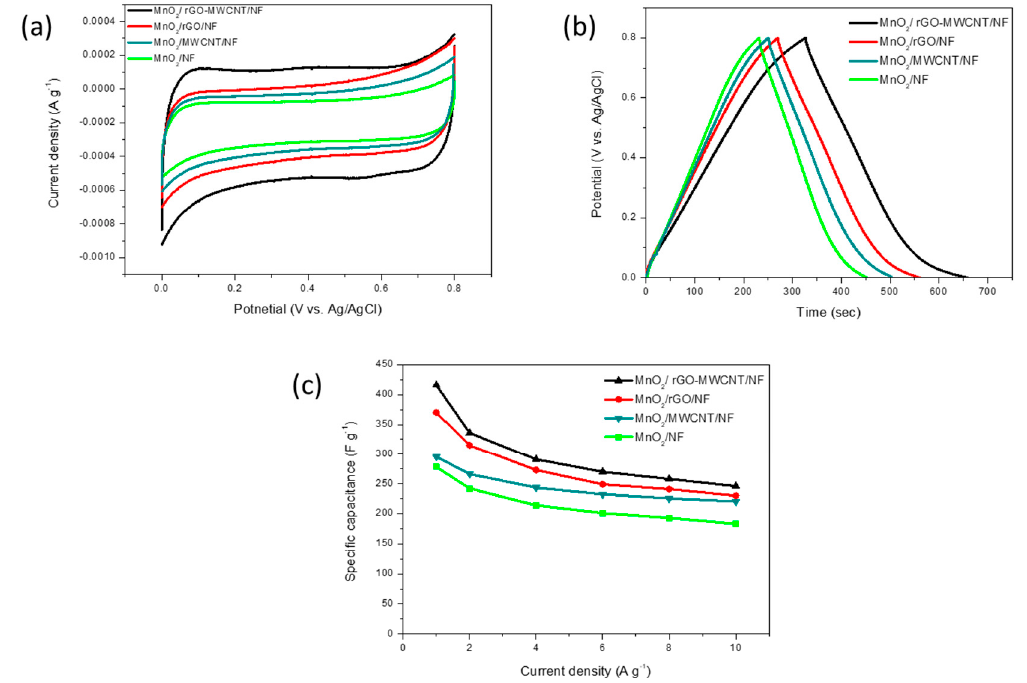
Figure 5. The capacitance performance of the as-deposited electrodes. ( a ) Cyclic voltammetry (CV) characteristics in a 1 M Na 2 SO 4 electrolyte at a scan rate of 5 mV · s − 1 , ( b ) galvanostatic charging-discharging (GCD) characterization at 1 A · g − 1 ; and ( c ) the relationship between the specific capacitance and current density from GCD examination.